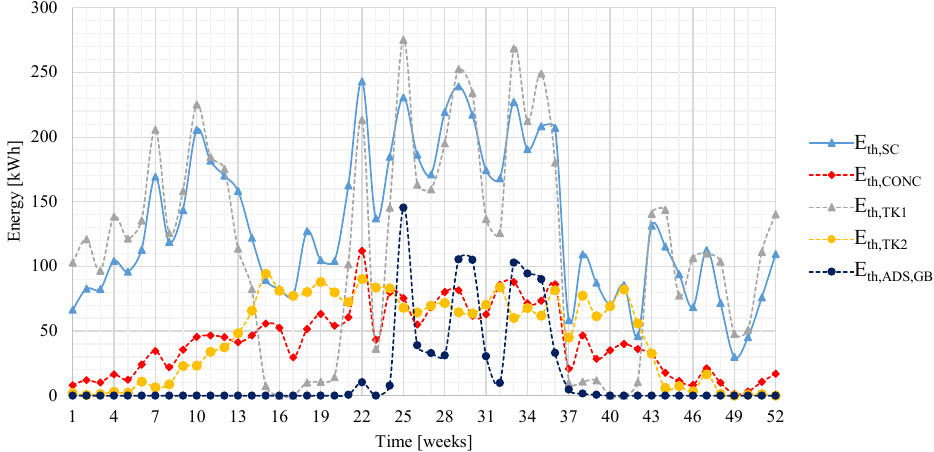
Figure 9. Thermal energy flows of SC, CONC, TK1, TK2, and GB for ADS, weekly analysis.